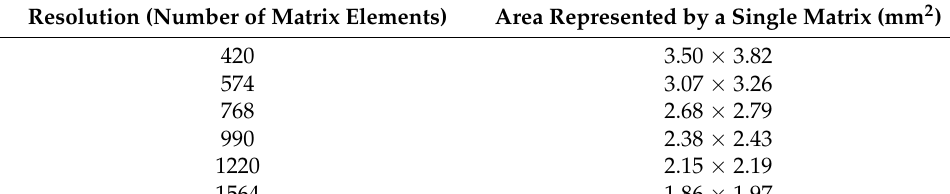
Figure 14. Representation of the area of the insole occupied by the COP.